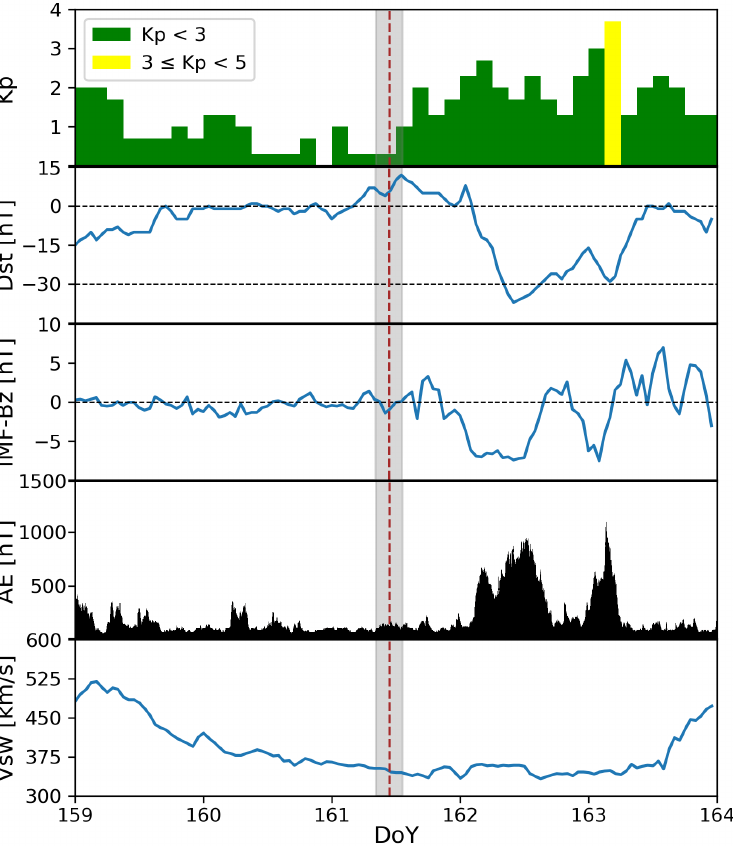
Figure 2. Variations of 3-hourly Kp, Dst, IMF-Bz, AE, and Vsw indices that characterize the geomag- netic conditions on 8–13 June 2021. P1–P4 time (light grey bar) and GE time (red dashed line) are also